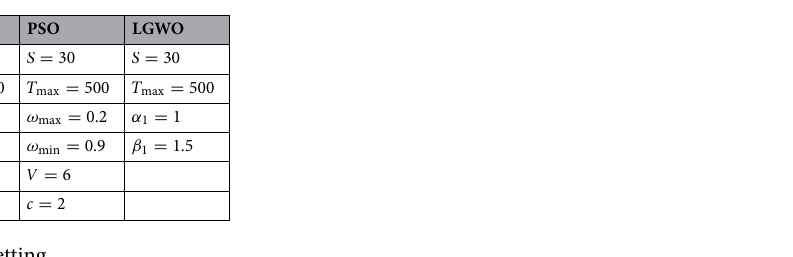
Table 4. Parameter setting.